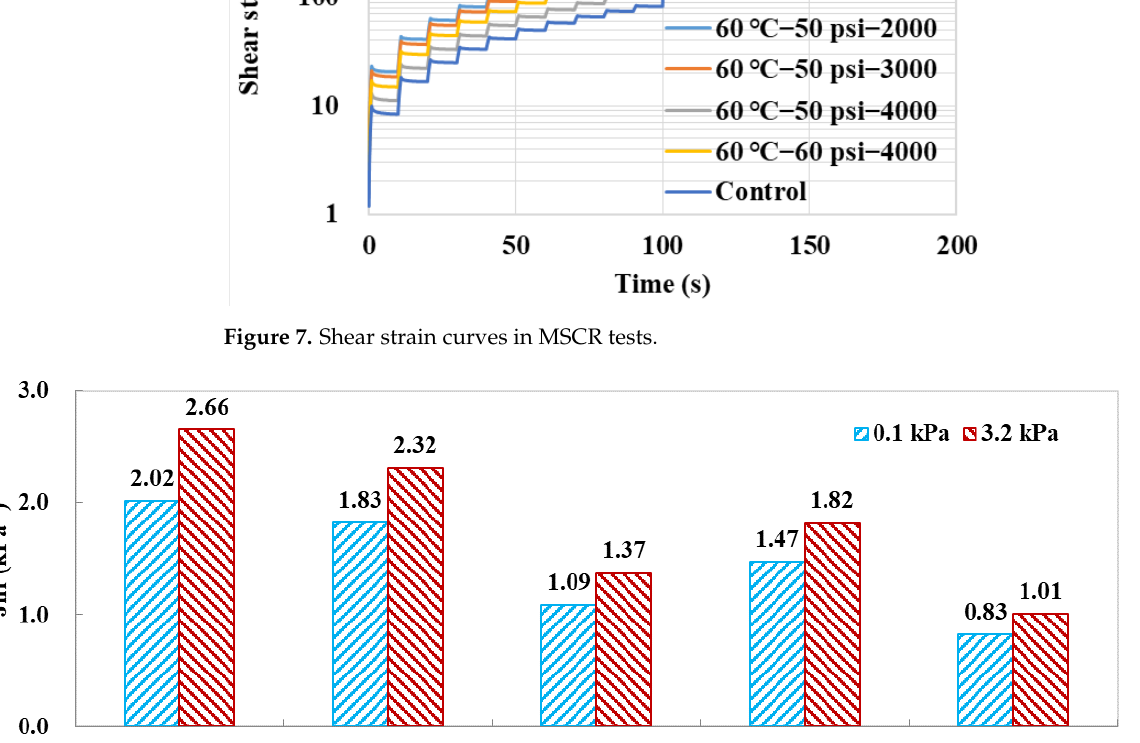
Figure 7. Shear strain curves in MSCR tests.